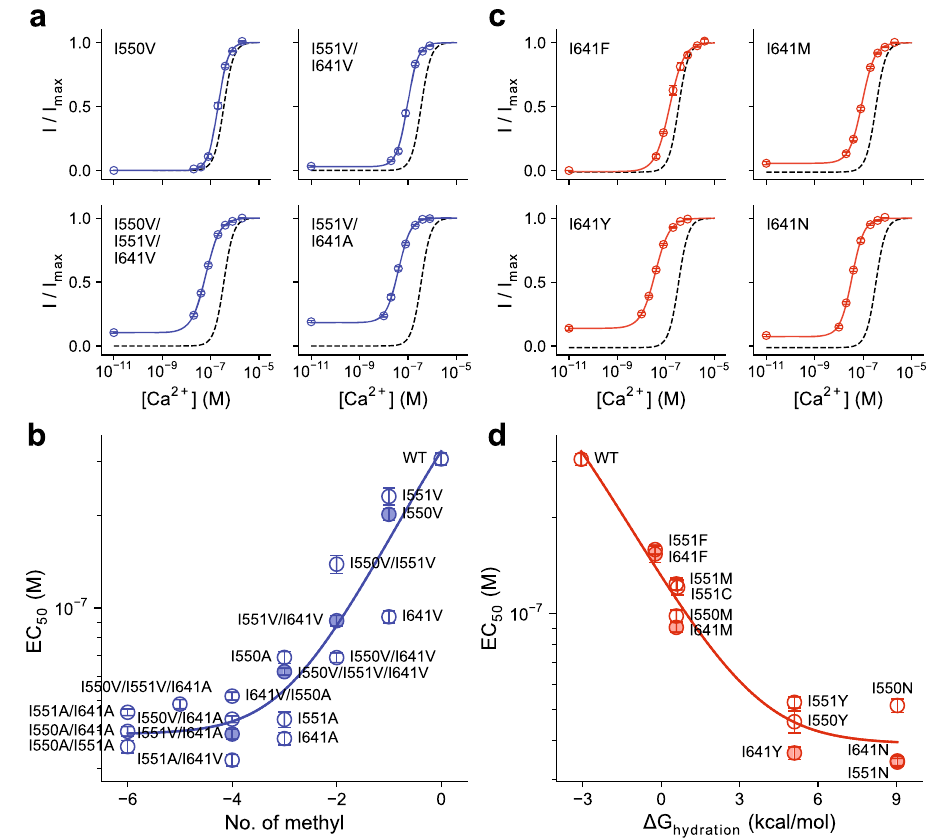
Fig. 4 Energetic contribution of hydrophobic volume and hydration energy of gate residues. a Selected concentration-response relations of mutants with decreasing hydrophobic volume of gate residues. b Relationship between EC 50 change and hydrophobic volume decrease. The effective contribution of each methyl group was estimated to be 0.83 ± 0.21 kcal/mol in stabilizing the closed state. c Selected concentration-response relations of mutants with increasing hydrophilicity of gate residues. d Relationship between EC 50 change and hydration energy. The fractional contribution of the residues ’ hydration energy was estimated to be 0.37 ± 0.11 in stabilizing the open state. a , c Data are averages of the indicated number of patches shown in Supplementary Tables 4 and 5 respectively, errors are SEM. Solid lines are fi ts to the Hill equation. Dashed lines are the relation of WT. b , d Filled symbols correspond to the mean EC 50 of the mutants shown in a and c respectively. Data are averages of the indicated number of patches shown in Supplementary Tables 4 and 5 respectively, errors are SEM. Solid line is a fi t to an MWC-type gating model (Eqs. 4 – 8, see “ Methods ” ). The two series were fi tted globally with shared binding constants. The errors of the estimates correspond to 95% con fi dence